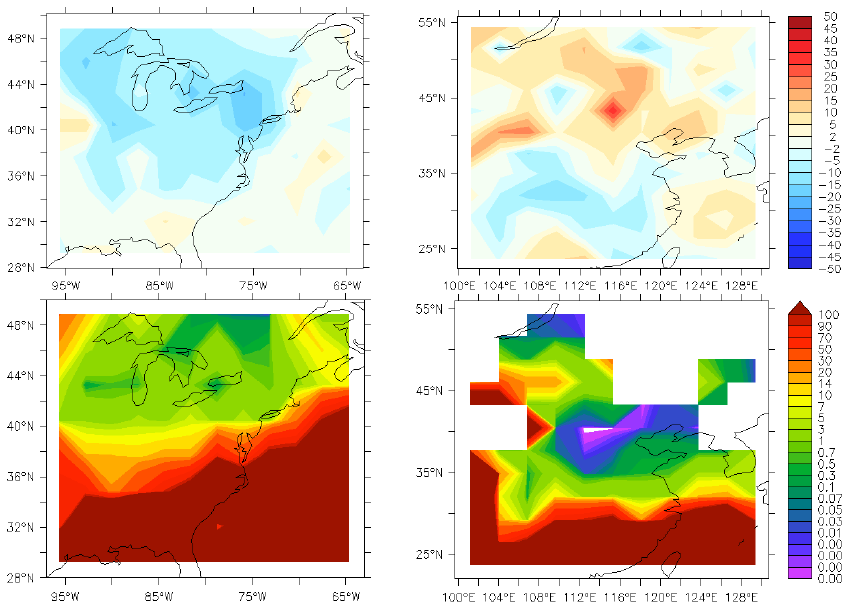
Fig. 4. Simulated monthly average relative changes (%) of aerosol sulphate (upper panels), and the ratio of in-cloud aqueous phase concen- trations of H 2 O 2 /HSO3 − (lower panels) in January without the gas phase oxidation of SO 2 (base_S3), over the eastern US (left) and China